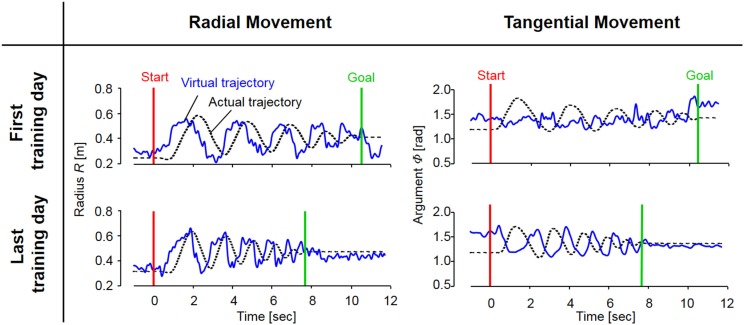
The evolution of actual and virtual trajectories in the radial and tangential directions (Subject #1). The virtual trajectory during fast spiral tracing for Subject #1 improved with voluntary training. In particular, the evolution of the virtual trajectory in the tangential direction was extreme, and it changed into a rhythmic movement that preceded the actual trajectory oscillating almost out of phase; the virtual trajectory in the radial direction developed into a trajectory that preceded the actual trajectory oscillating almost in phase. The oscillation frequencies of the virtual trajectory in both directions became shorter in accordance with those of the actual trajectory. These evolutionary characteristics of the virtual trajectory are representative of those observed for all eight subjects.